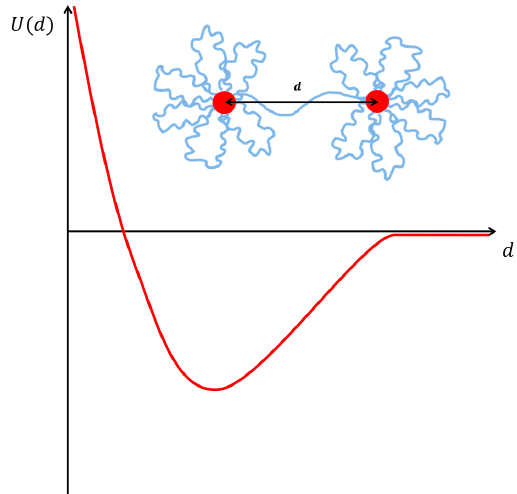
Figure 8. Schematic representation of the interaction potential between micelles (microemulsions)